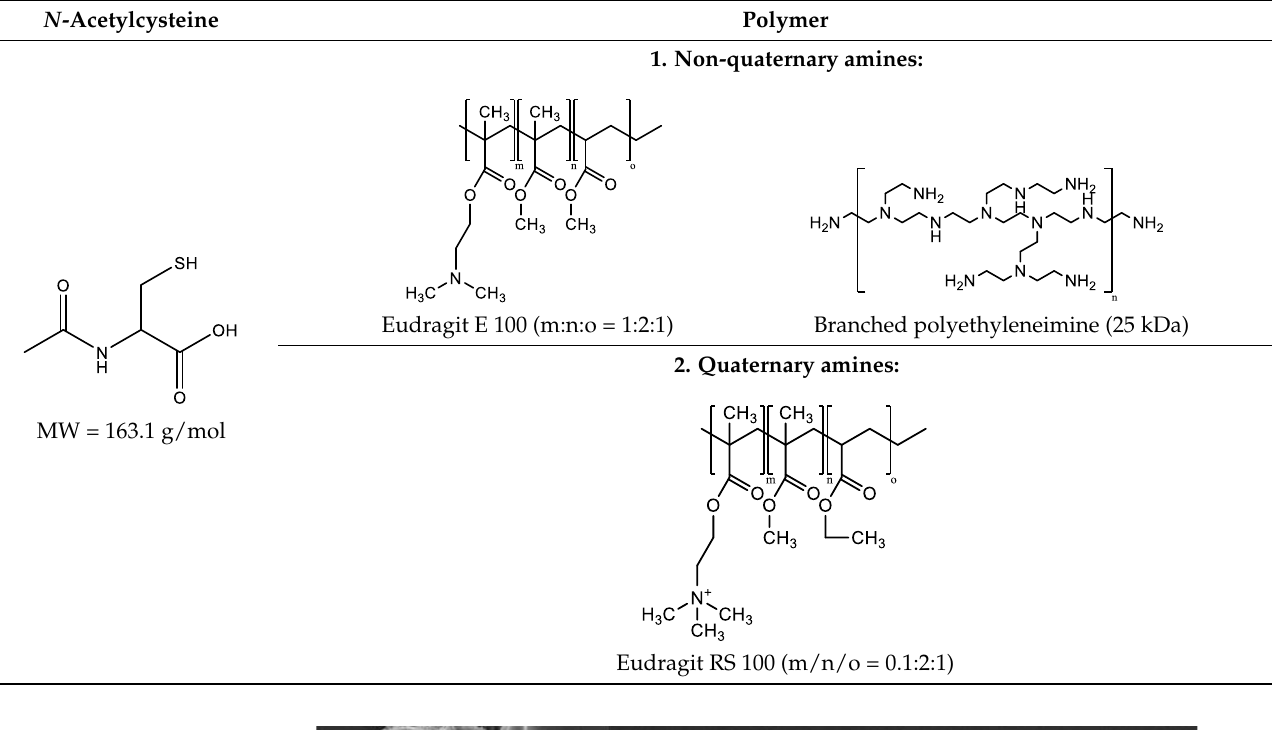
Table 1. N -acetylcysteine target ionic complexes with selected cationic polymers.